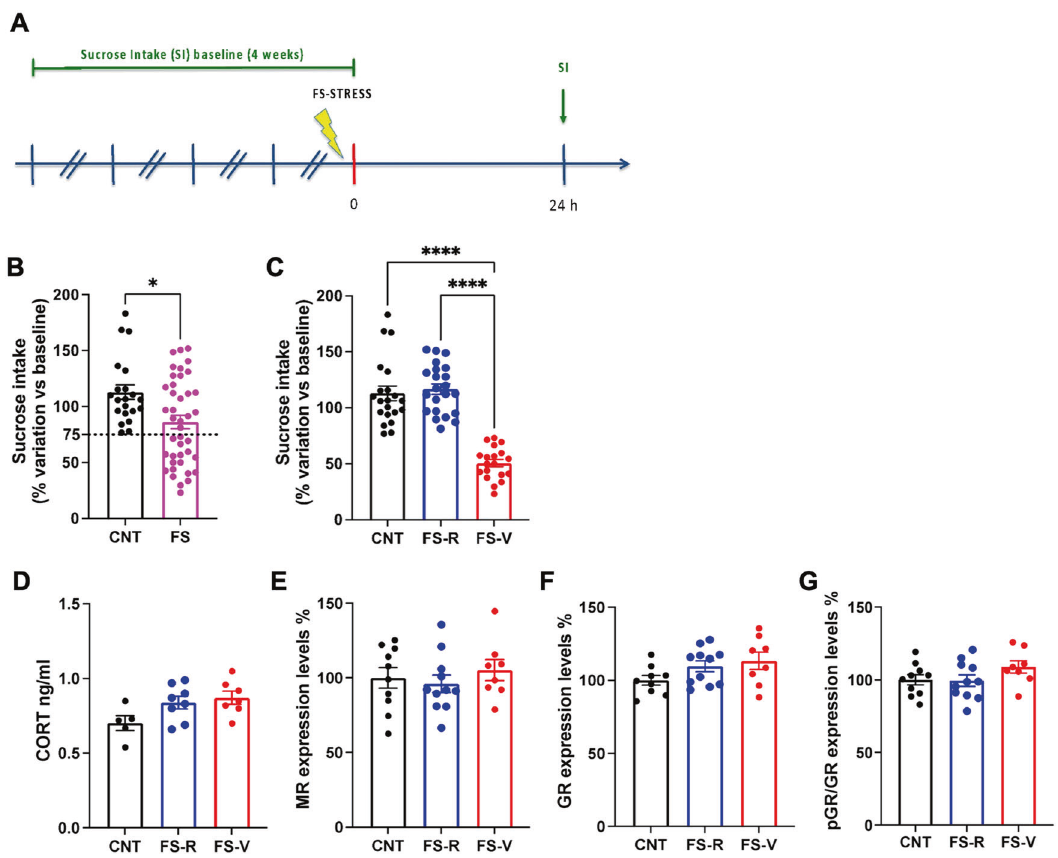
Fig. 1 Generation of a rat model of resilience and vulnerability to acute footshock stress. A Experimental plan timeline. Basal (spontaneous) sucrose intake was established exposing the rats to the sucrose intake test twice a week for 4 weeks. Animals were then subjected to a single session of FS and sucrose intake test was performed again 24 h after FS. B Sucrose intake measured 24 h after FS. Mann Whitney test, * p < 0.05; N = 21 (CNT), 41 (FS). C Sucrose intake measured 24 h after FS with separation of resilient (FS-R) and vulnerable (FS-V) rats applying a 75% of sucrose intake cut-off. Kruskal-Wallis test, Dunn ’ s post-hoc test: **** p < 0.0001; N = 21 (CNT), 22 (FS-R), 19 (FS-V). D Corticosterone (CORT) serum levels. One-way ANOVA; N = 5 (CNT), 8 (FS-R), 7 (FS-V). E Mineralocorticoid receptor (MR) protein expression levels in PFC nuclear fraction. One-way ANOVA; N = 10 (CNT), 11 (FS-R), 8 (FS-V). F Glucocorticoid receptor (GR) protein expression levels in PFC nuclear fraction. One-way ANOVA; N = 9 (CNT), 11 (FS-R), 8 (FS-V). G phospho-Ser 203 -GR/GR protein expression levels in PFC nuclear fraction. One-way ANOVA; N = 10 (CNT), 11 (FS-R), 8